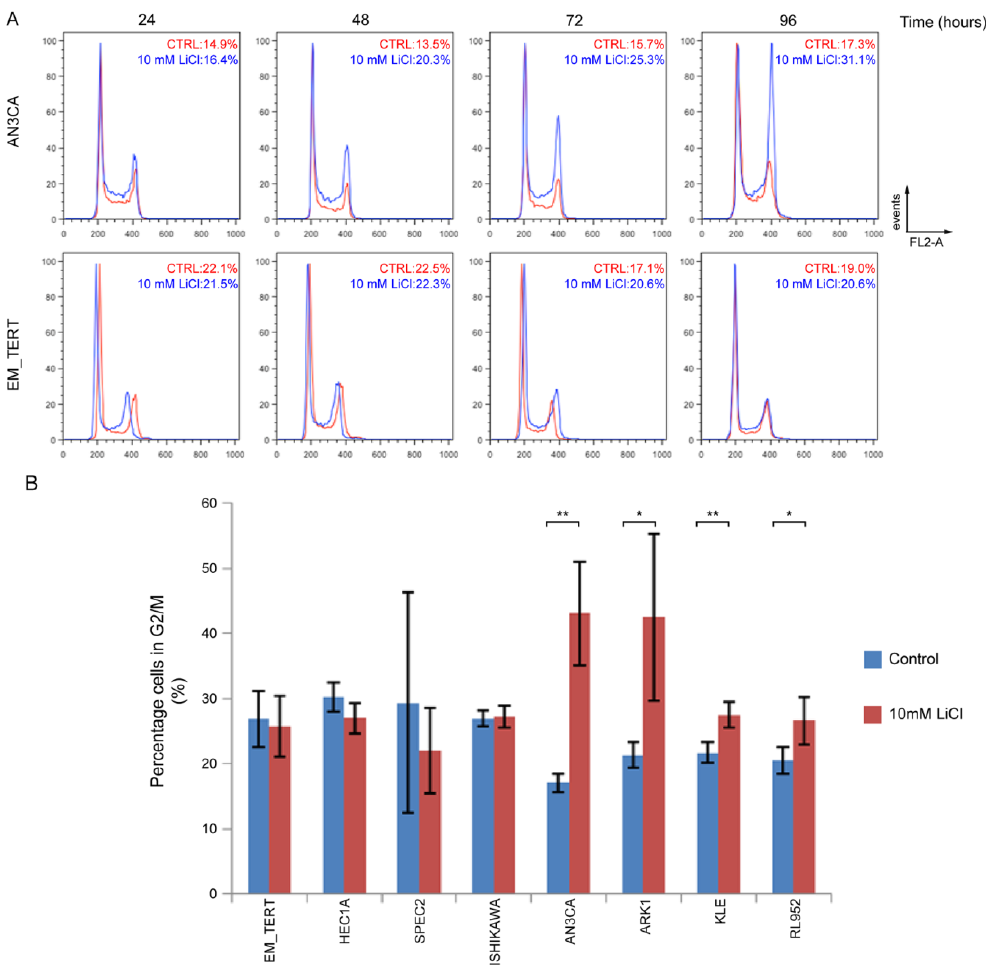
Figure 3. Endometrial cancer cells treated with LiCl accumulate at G2/M phase. ( A ) Representative FACS analyses on cell cycle progression in untreated (red) and 10 mM LiCl-treated (blue) endometrial cell lines. In AN3CA cells, percentage of cells in G2/M phase steadily increased and peaked at 96 h. No such changes were detected in the EM-TERT cell line. Percentages of cells in G2/M are indicated; ( B ) Quantification of G2/M cell percentages at 96 h comparing 10 mM LiCl-treated vs. control cells in multiple endometrial cell lines. At least three independent experiments were performed for each cell line. * denotes p < 0.05 and ** denotes p <